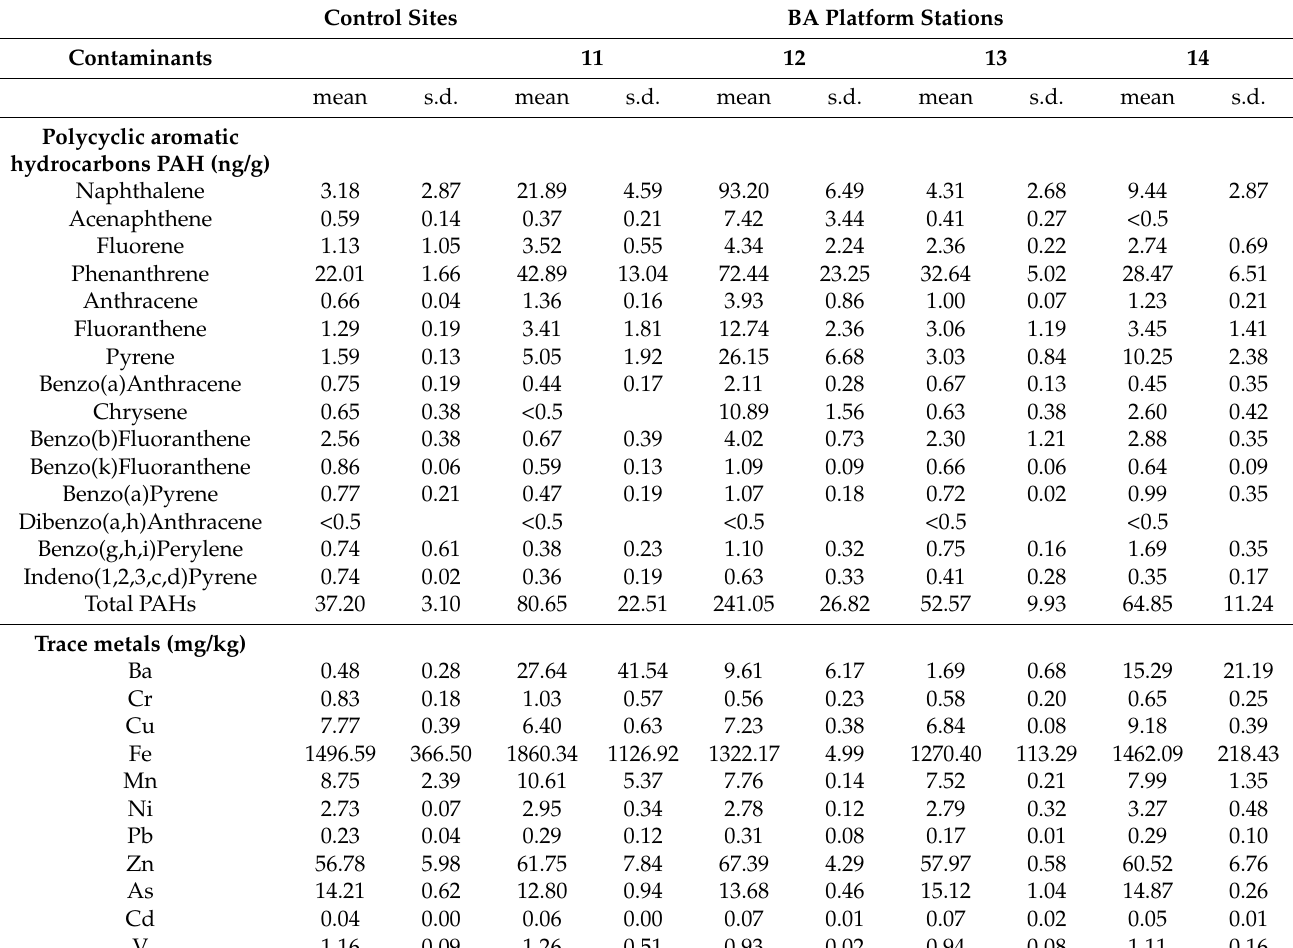
Table 2. Concentrations of contaminants in the Hediste diversicolor polychaete exposed to sediments sampled around offshore platform called BA and control sites. Mean ± standard deviation (s.d.).